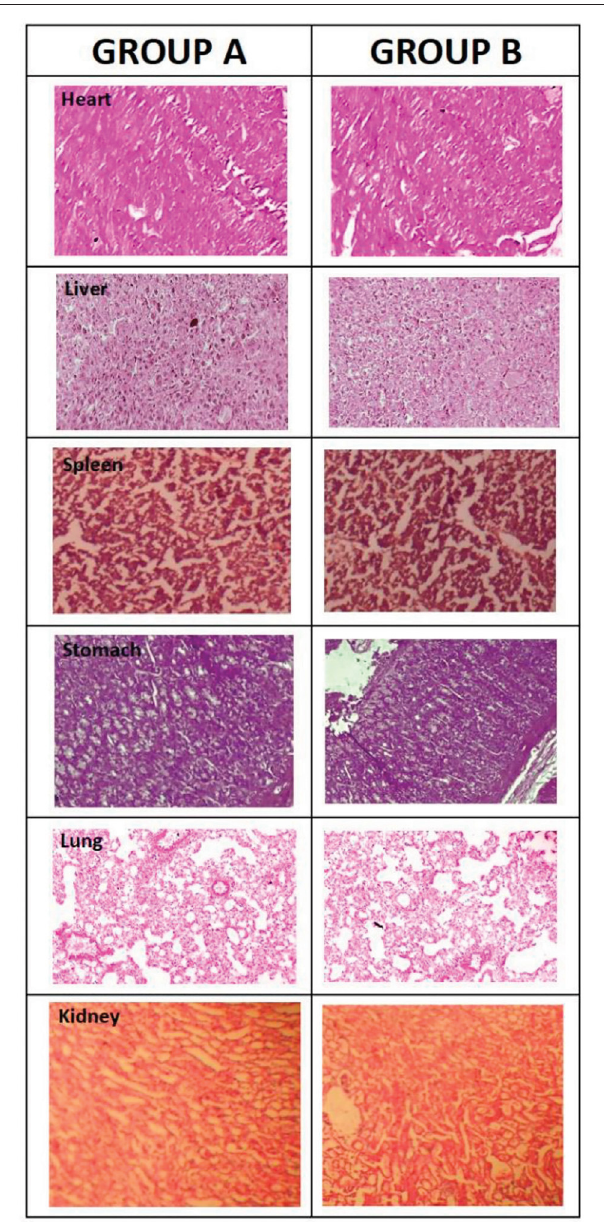
FIGURE 10 | Histopathological observations of tissues from organs of group A and group B including Heart, Liver, Spleen, Stomach, Lung, Kidney used in acute oral toxicity